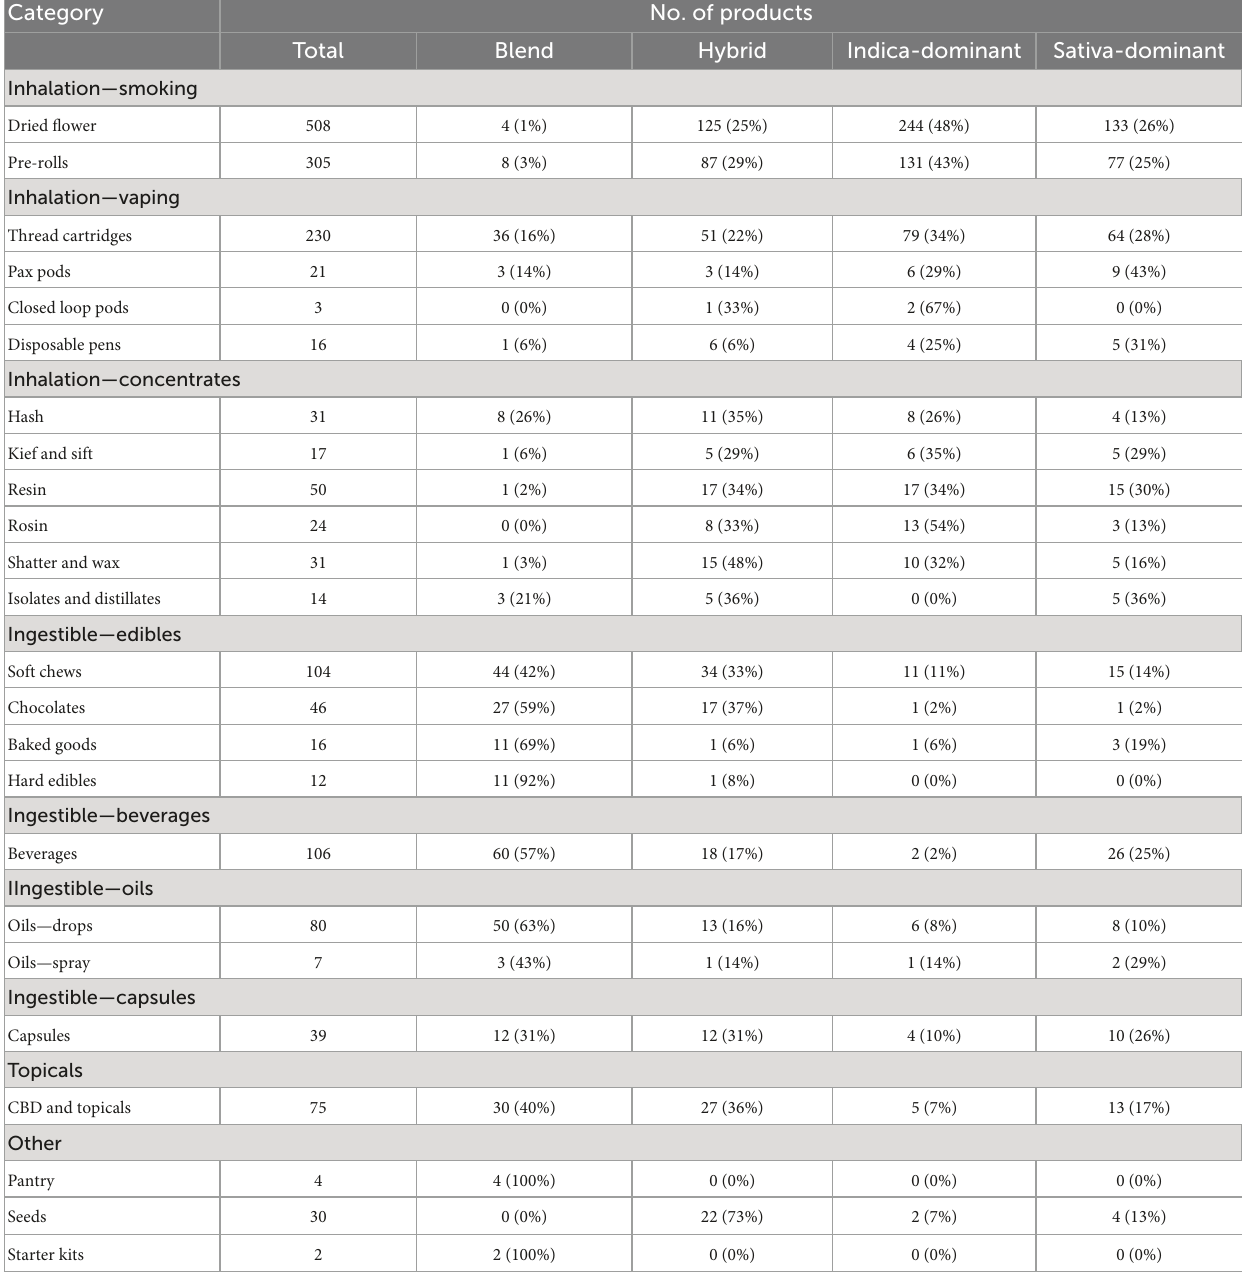
TABLE 3 Plant type by product type (first quarter of